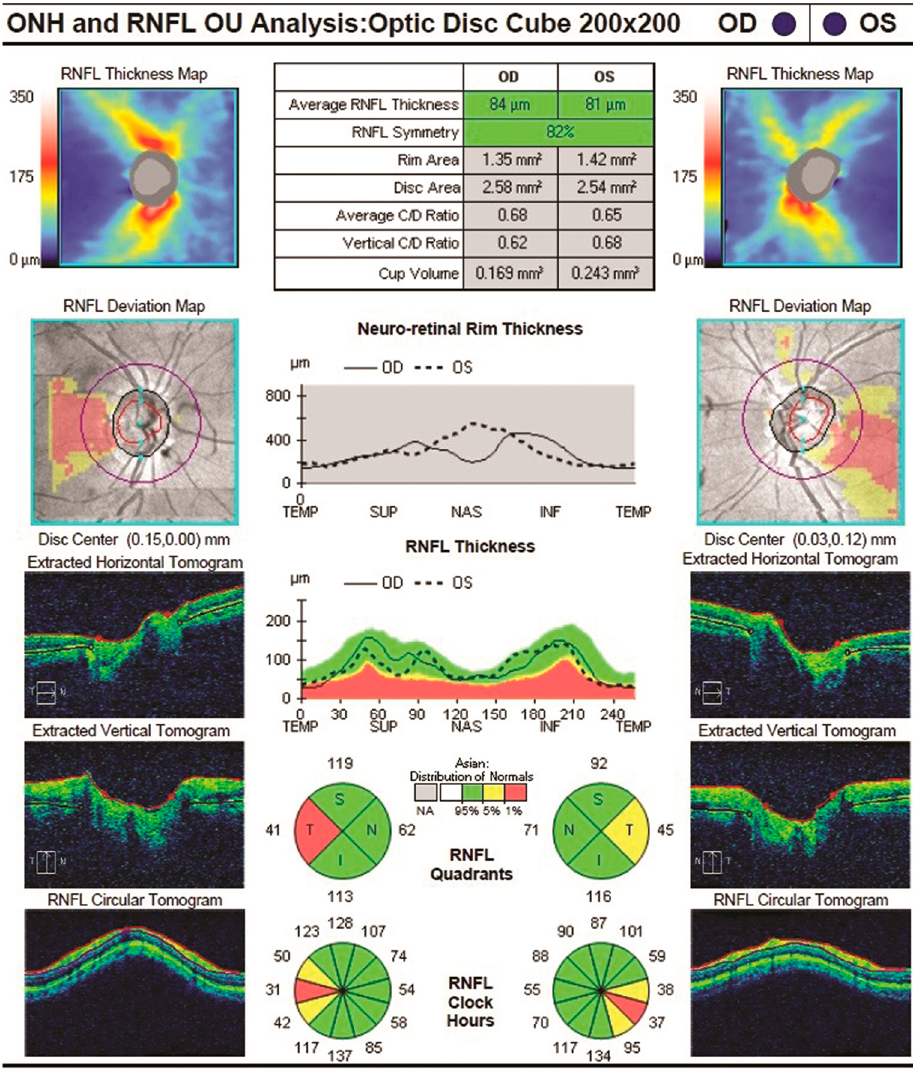
Figure 6. AD patient OCT image. Inner and outer retinal layer (IRL and ORL) [52].